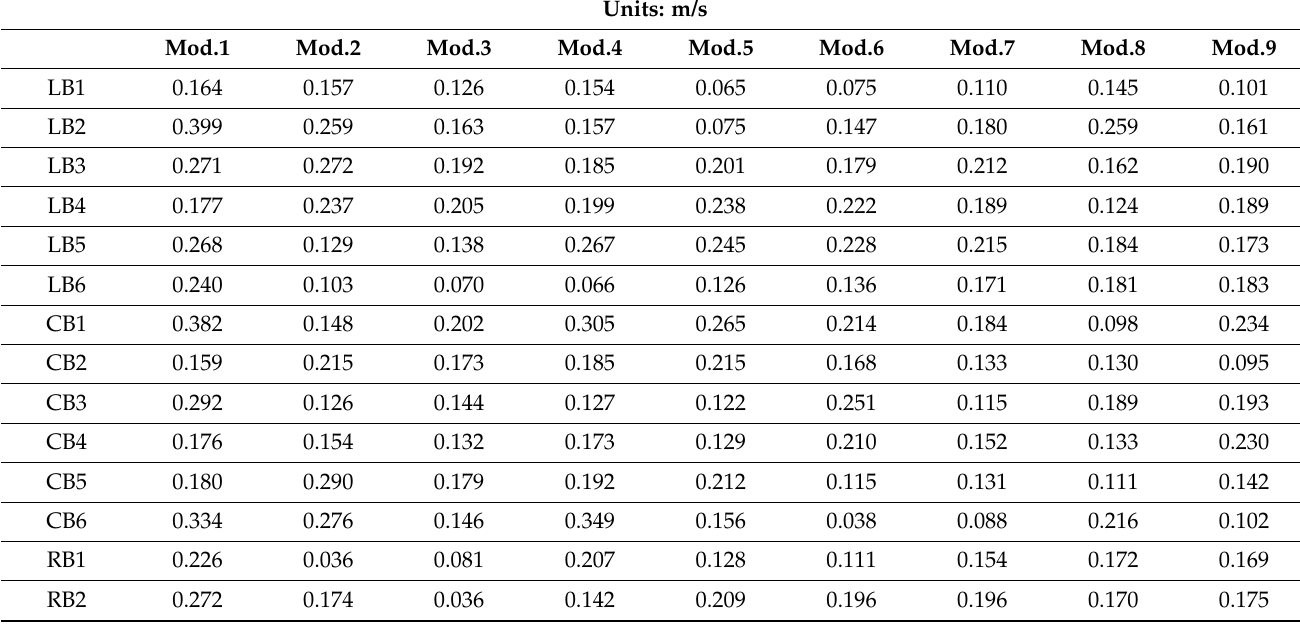
Table 6. Air flow velocity at the lower 18